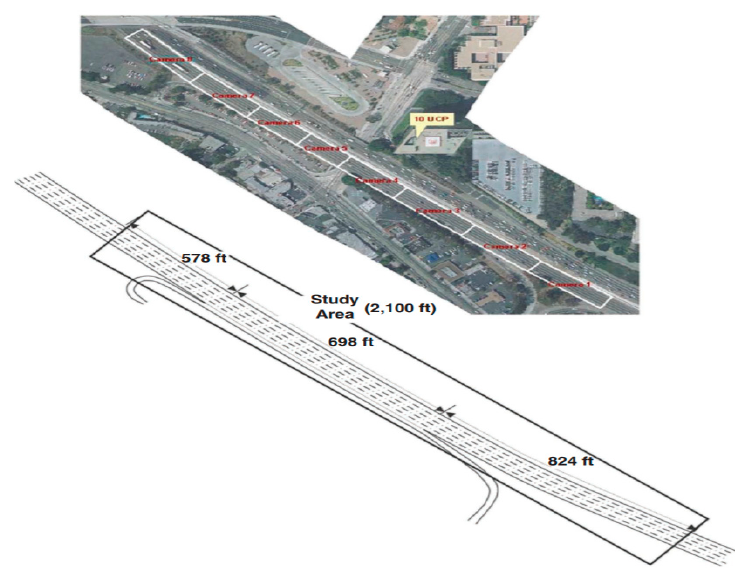
Figure 8. Image from the US highway 101 dataset [31].